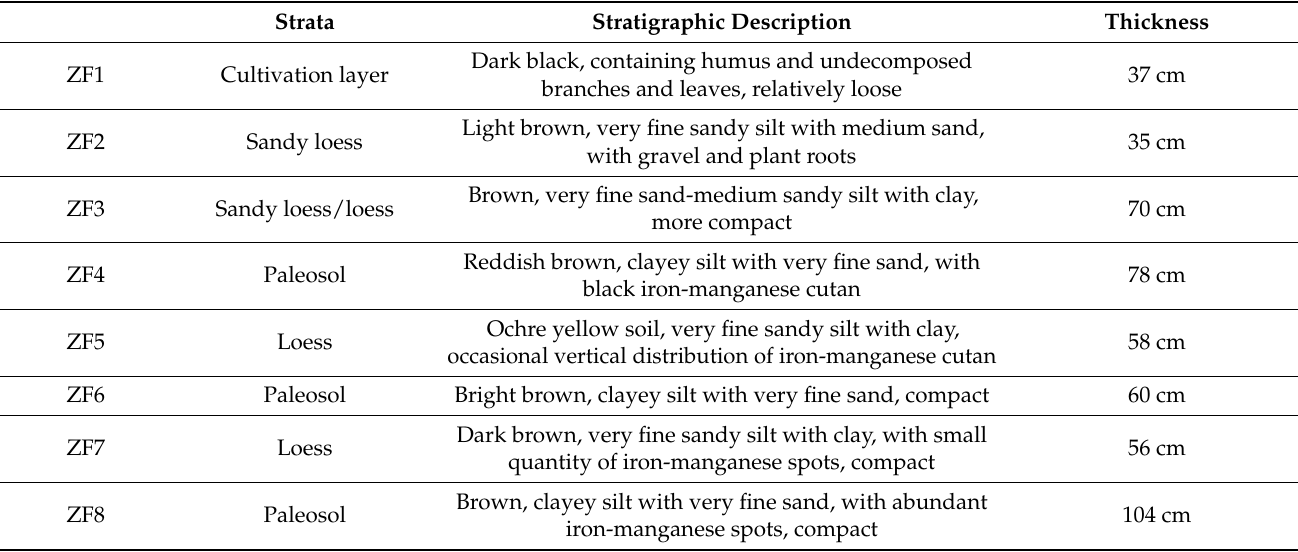
Table 1. Sedimentary facies of MIS 5 period within the ZFS.